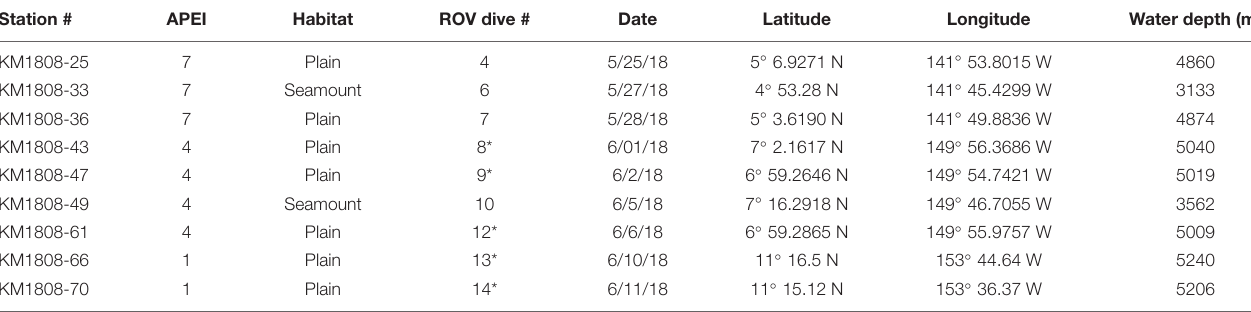
TABLE 1 | Station overview for ROV dives from which sediment and nodules were collected for eDNA. Station #